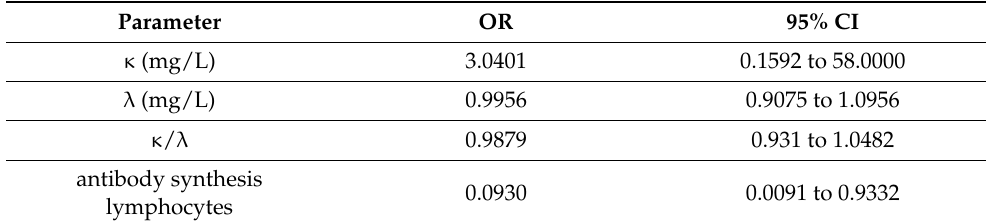
Table 4. Odds ratio of the severity of the disease related to hospitalization of patients in the intensive care unit (COVID ICU) ( n =